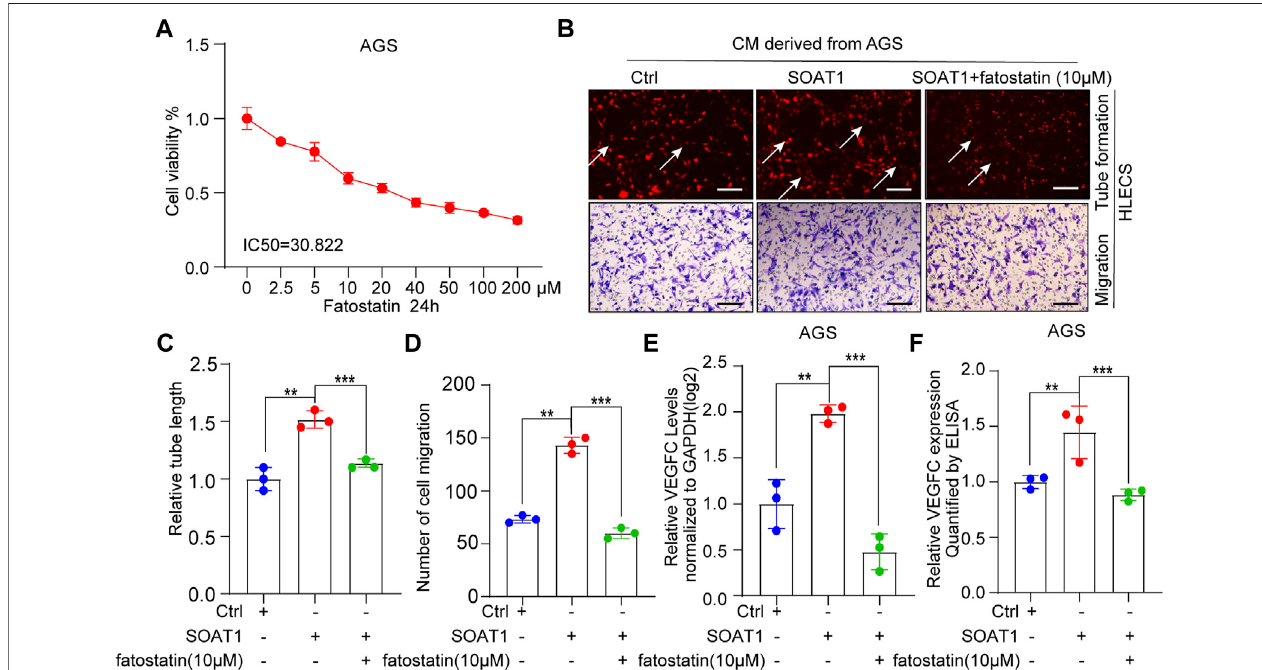
FIGURE 7 | SOAT1 accelerates GC lymphangiogenesis by upregulating the activity of SREBP1 and SREBP2. (A) Relative cell viability was measured by CCK-8 assay after fatostatin treatment for 24 h at multiply concentrations (0, 2.5, 5, 10, 20, 40, 100, and 200 µM). (B – D) Representative images (A) and quanti fi cation results (C,D) of the tube formation and transwell migration assays of HLECs cultured with conditioned medium collected from SOAT1-overexpressing AGS cells treated with fatostatinorthecorrespondingcontrols. (E) TheexpressionlevelofVEGFCwasmeasuredbyqRT-PCRinSOAT1-overexpressingAGScellstreatedwithfatostatin or their corresponding controls. (F) ELISA assay of VEGFC expression in conditioned medium collected from the SOAT1-overexpressing AGS cells treated with fatostatin or their corresponding